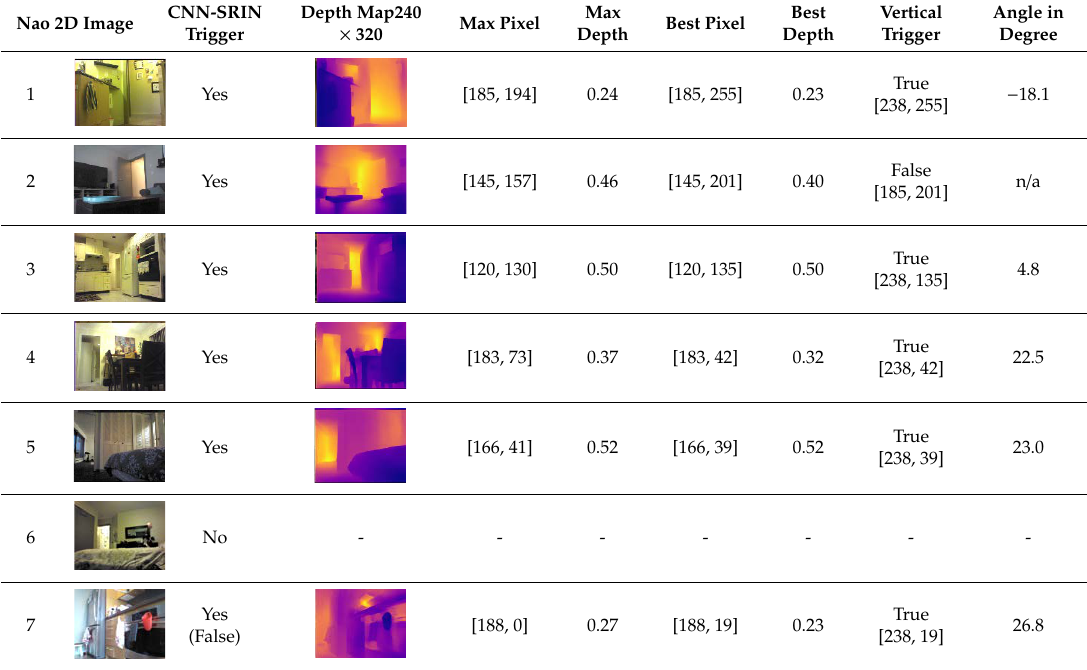
Table 3. Real-time experiment results: depth to angle values for controlling Nao robot.